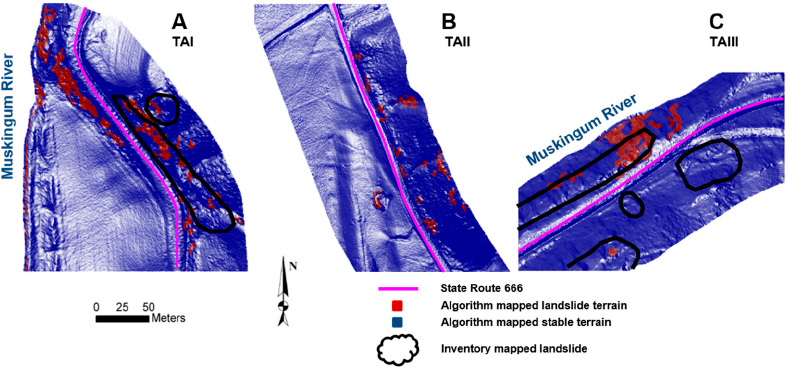
Figure 9. Mapped slides with underlying DEM for TAI ( A ), TAII ( B ) and TAIII ( C ).